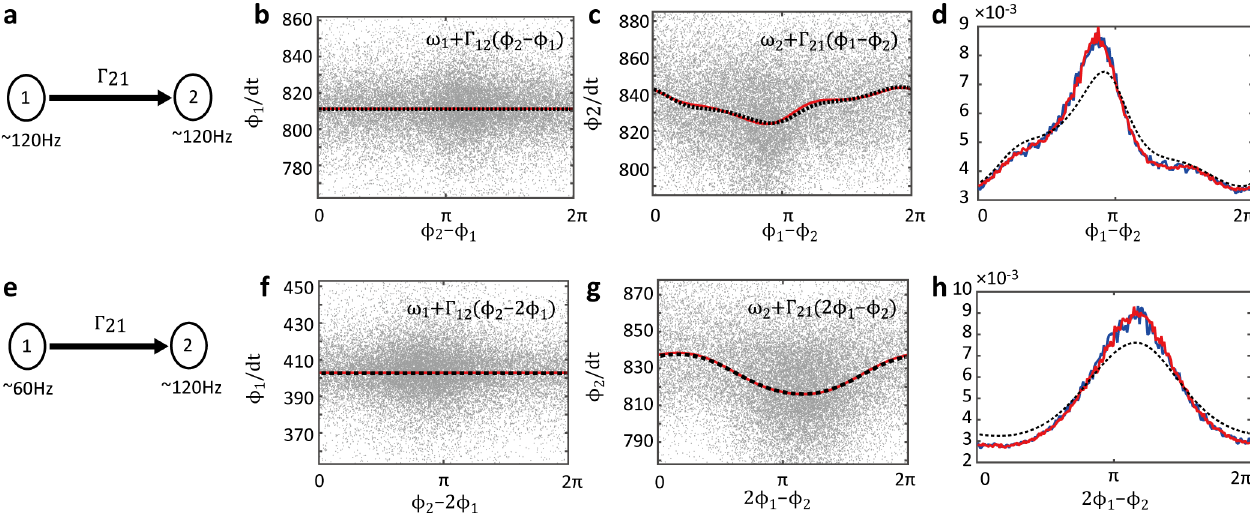
Fig 4. Estimated coupling function of electronic circuit. (a) The diagram shows the coupling direction between oscillators of the same frequency. The first oscillator was coupled to the second oscillator. (b) The red line shows the estimated phase coupling function with the natural frequency in the same-frequency coupling case. The dashed black line shows the theoretical coupling function. The coupling function from the second to first oscillator Γ 12 is identically zero. When there is no interaction, the coupling function is nearly zero. The gray dots show the experimental data points. (c) The coupling functions from the first to second oscillator Γ 21 . (d) The blue line shows the phase difference histogram of the experimental data in the case of 1:1 phase locking (experimental histogram). The red line shows the simulated histogram calculated in the phase oscillator model estimated from the experimental data (estimated histogram). The dashed black line shows the simulated histogram calculated in the phase oscillator model using the theoretical natural frequencies and coupling functions (theoretical histogram). (e) In the cross-frequency coupling case, the slow oscillator was coupled to the fast oscillator. (f) The coupling function from the fast to slow oscillator is identically zero. (g) The coupling function from the slow to fast oscillator. (h) The experimental, estimated, and theoretical histogram in the 1:2 phase-locking case.